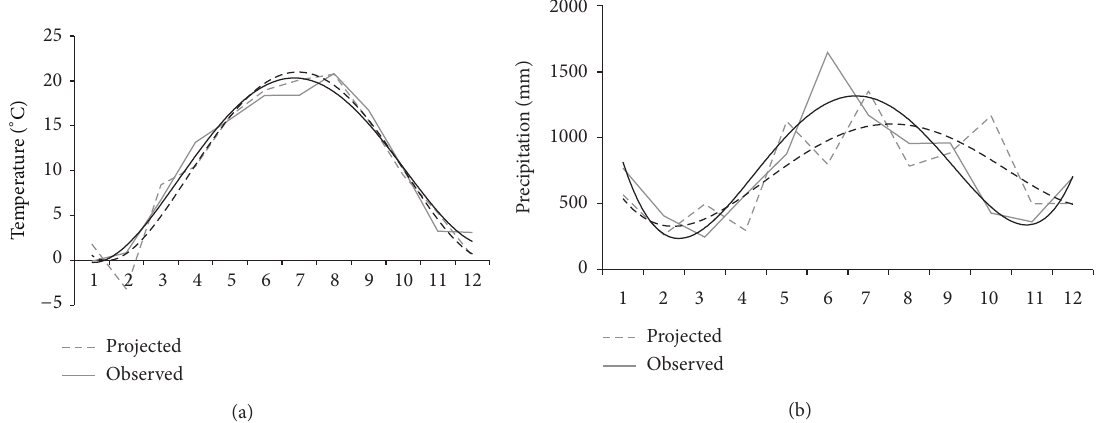
Figure 5: (a) Difference between observed and projected surface temperature in Central Europe in 2010. (b) Difference between observed and projected precipitation in Central Europe in